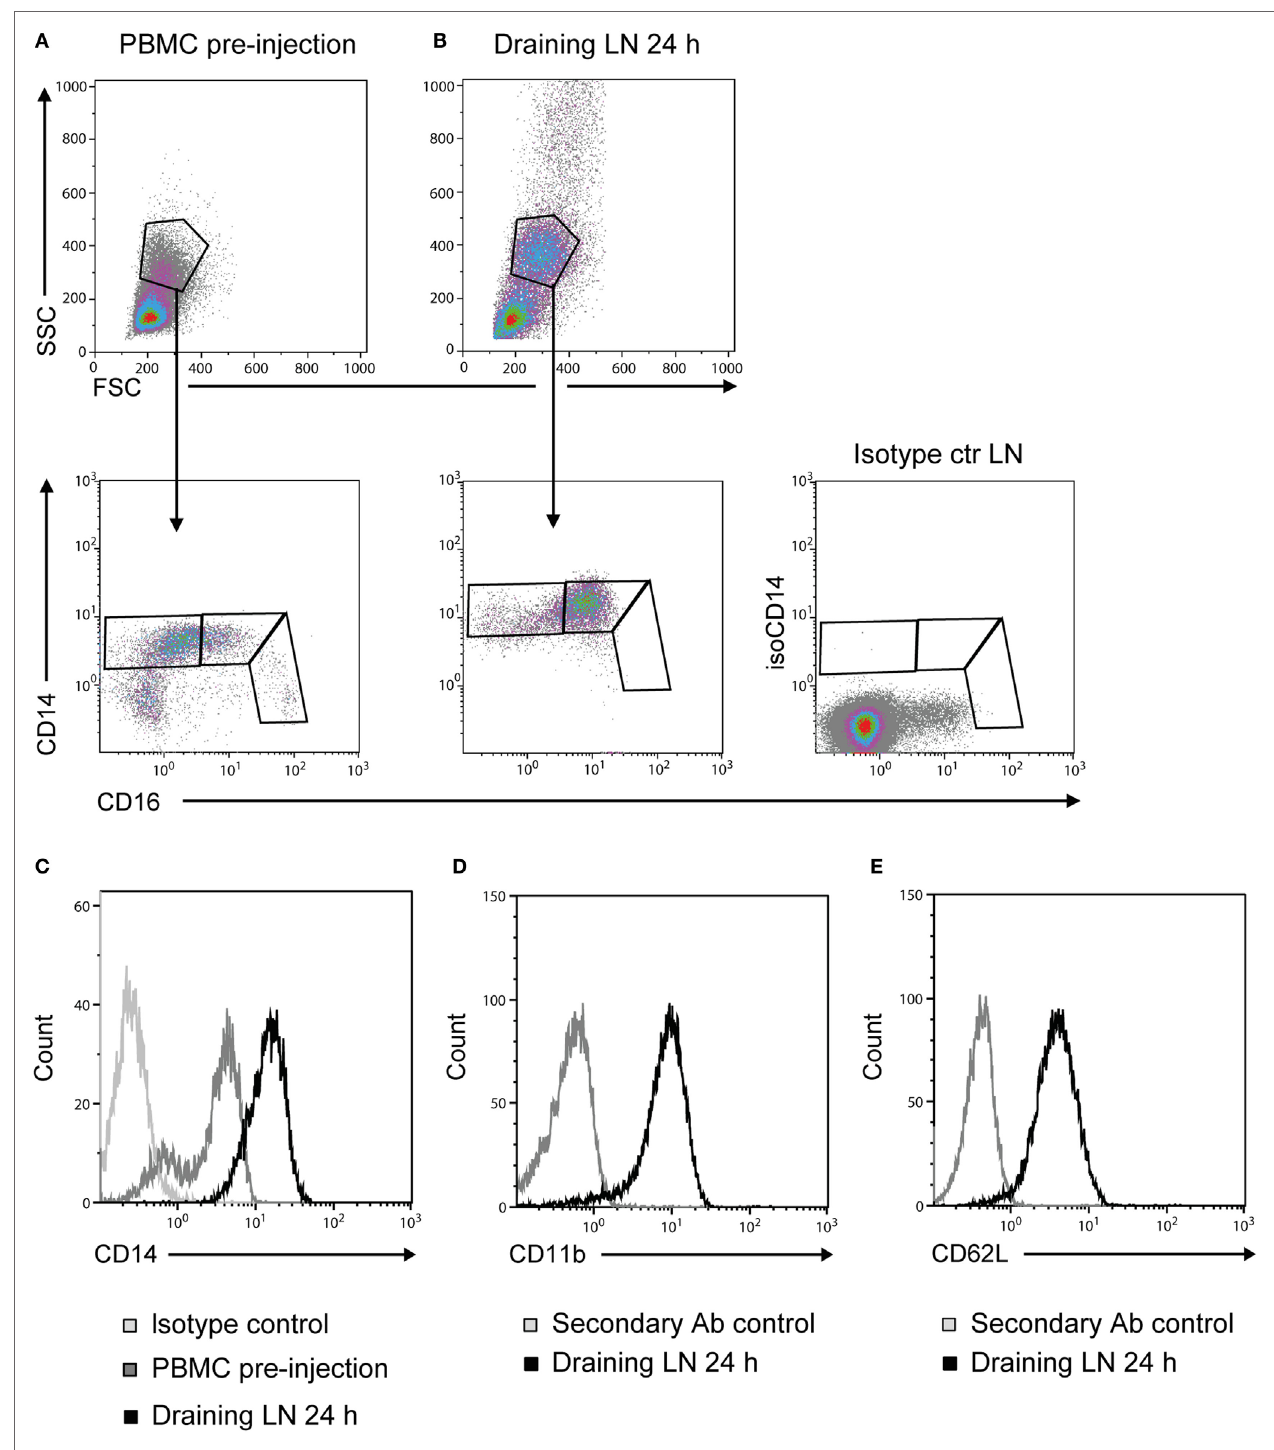
FigUre 3 | Phenotype of recruited monocytes . Density plots of live cells (upper panels) from PBMC pre-injection (a) and the draining LN at 24 h post-injection (B) . Plots from one representative animal are presented. Monocytes were further gated into subsets based on their expression of CD14 and CD16 (lower panels). Isotype control for CD14 on live cells from LN is shown far right. (c) CD14 expression on cells from the monocyte gate [as gated in (a,B) ]. Histograms show the isotype control for CD14 (light gray line), PBMC baseline (gray line), and draining LN at 24 h (black line). (D) CD11b expression and (e) CD62L expression on CD14 ++ cells. Histograms show the secondary Ab control (gray line) and the draining LN at 24 h (black